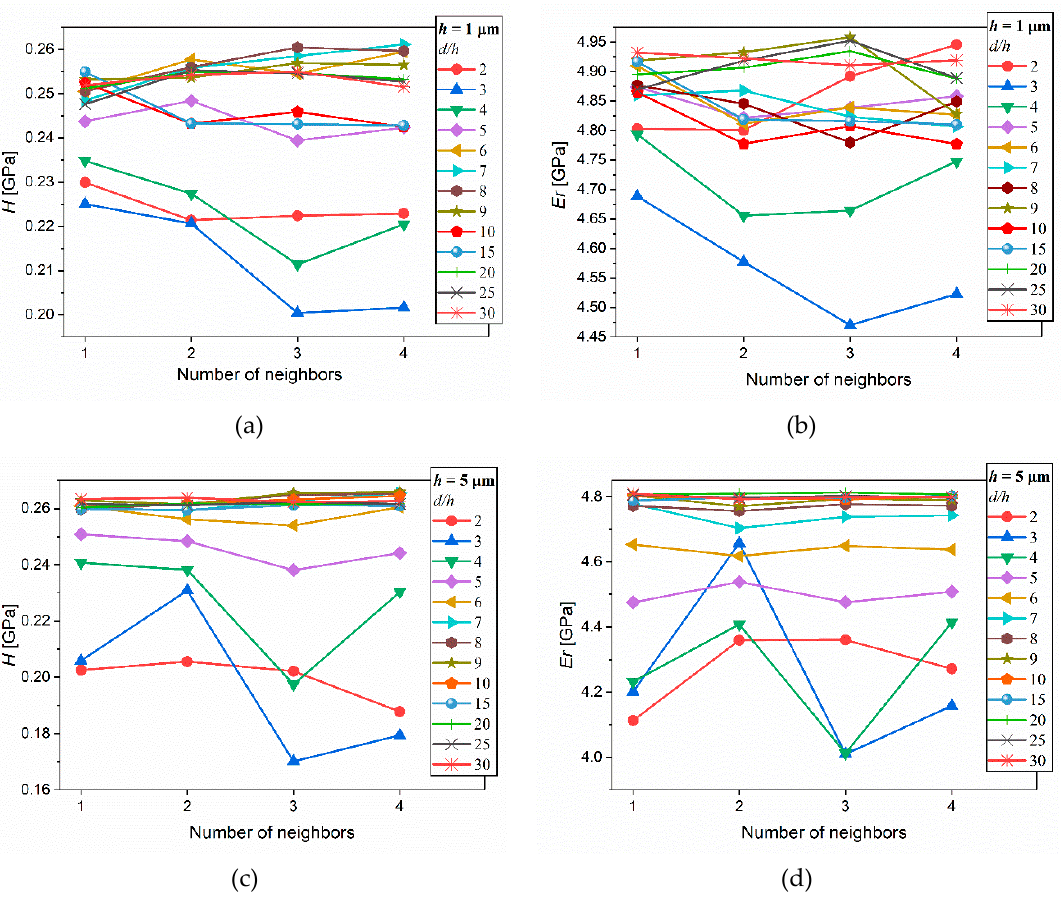
Figure 9. ( a ) and ( c ) hardness and ( b ) and ( d ) reduced modulus as a function of the number of Figure 9. ( a , c ) hardness and ( b , d ) reduced modulus as a function of the number of neighboring indents neighboring indents and spacing for maximum depth of ( a ) and ( b ) 1 µm; ( c ) and ( d ) 5 µm. and spacing for maximum depth of ( a ) and ( b ) 1 µ m; ( c ) and ( d ) 5 µ